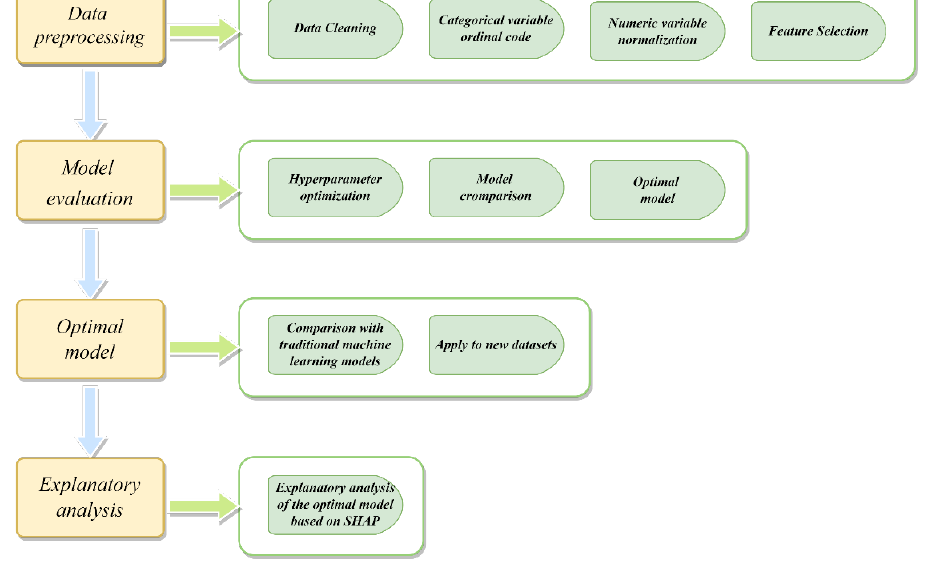
Figure 1. Predictive model flow chart.